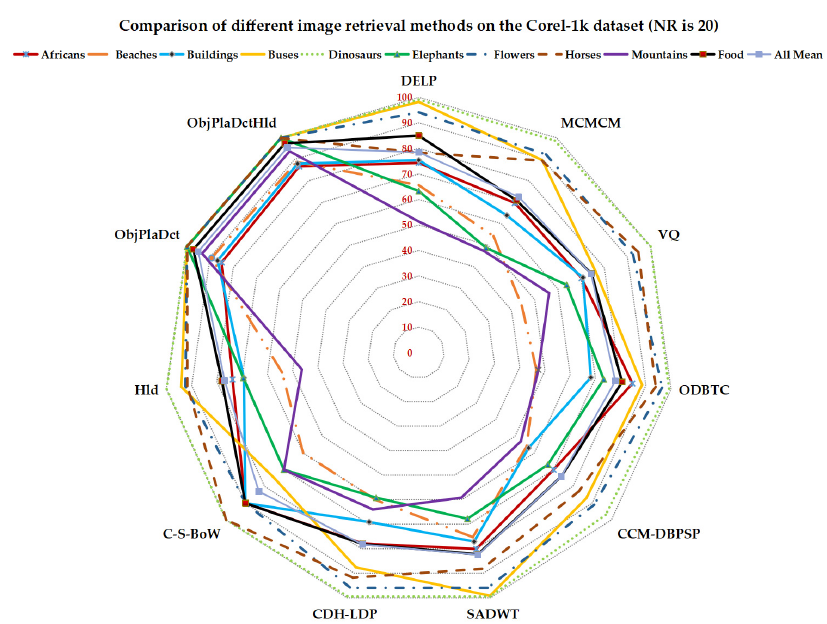
Figure 6. Radar chart of retrieval results using different image retrieval methods on the Corel-1k dataset (Top NR is 20).